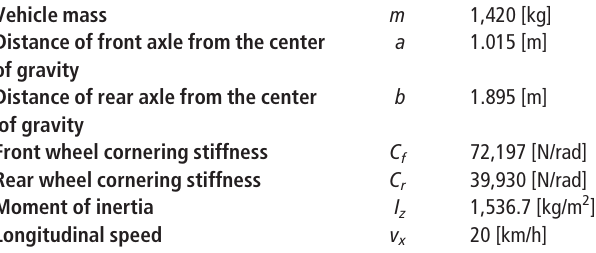
Table 4 Main parameters of the vehicle